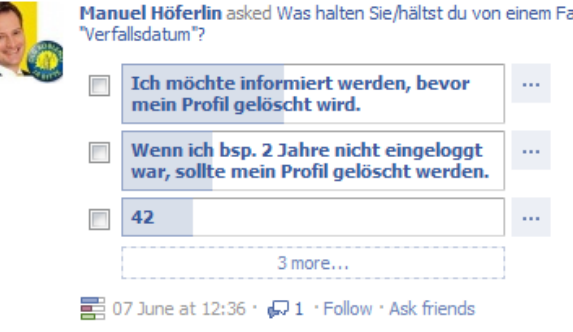
Figure 1: Facebook profile of Manuel Hoeferlin (Member of German